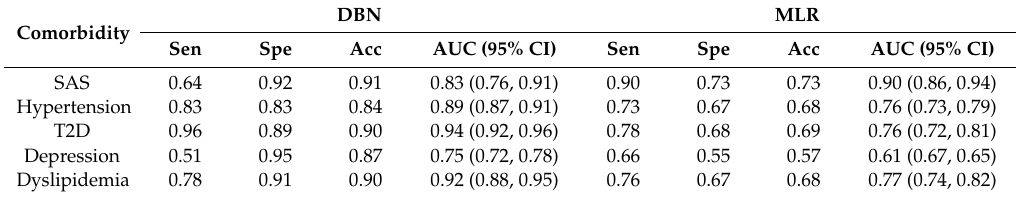
Table 3. Performance metrics of the DBN and MLR model for predicting the 5-year comorbidities. DBN Comorbidity